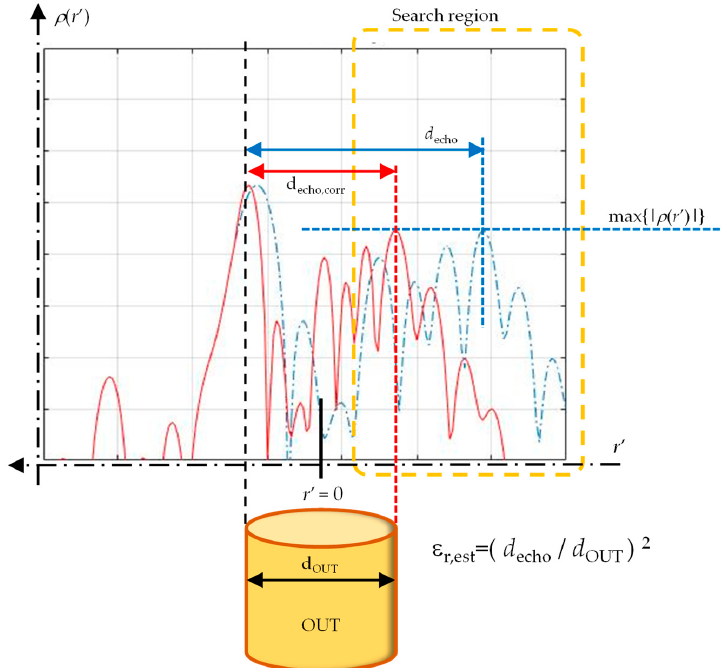
Figure 2. Methodology to estimate the permittivity of the object-under-test (OUT) ( ε r,est ) from scattered field measurements given the thickness of the OUT (d OUT ).